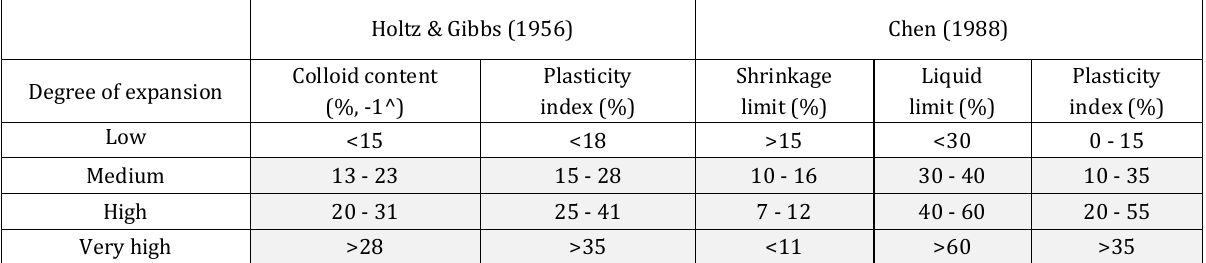
Fig. 6. Soil swelling potential on [40] diagram Fig. 7. Soil swelling potential on [41] diagram Table 3. Chen (1988) and Holtz & Gibbs (1956) degree of an expansion/swelling table (the grey shading is the physical characteristics value in all soil